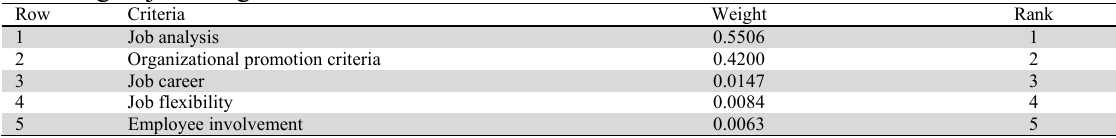
∑ M kl Key criteria